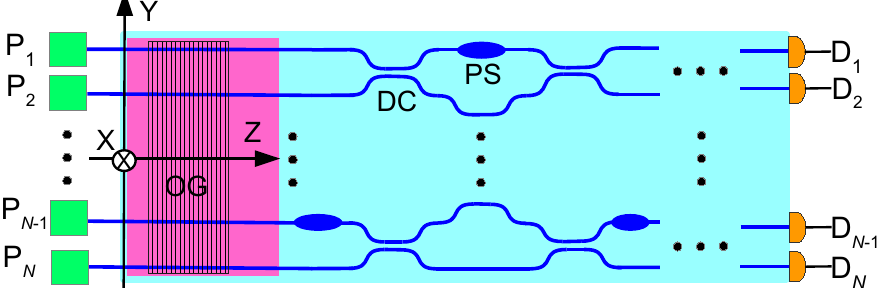
Figure 6. A general device formed with N paths (channel waveguides) in active ( left ) and passive ( right ) sections of a hybrid glass substrate. An optical grating (OG) in the rare-earth-doped glass section (the left part of the substrate) is used to implement a laser structure which, pumped by beams P j , ( j = 1, . . . , N ), generates N laser signals; several directional couplers (DC) and phase shifters (PS) in the passive section perform linear optical transformations. N detectors D j are also